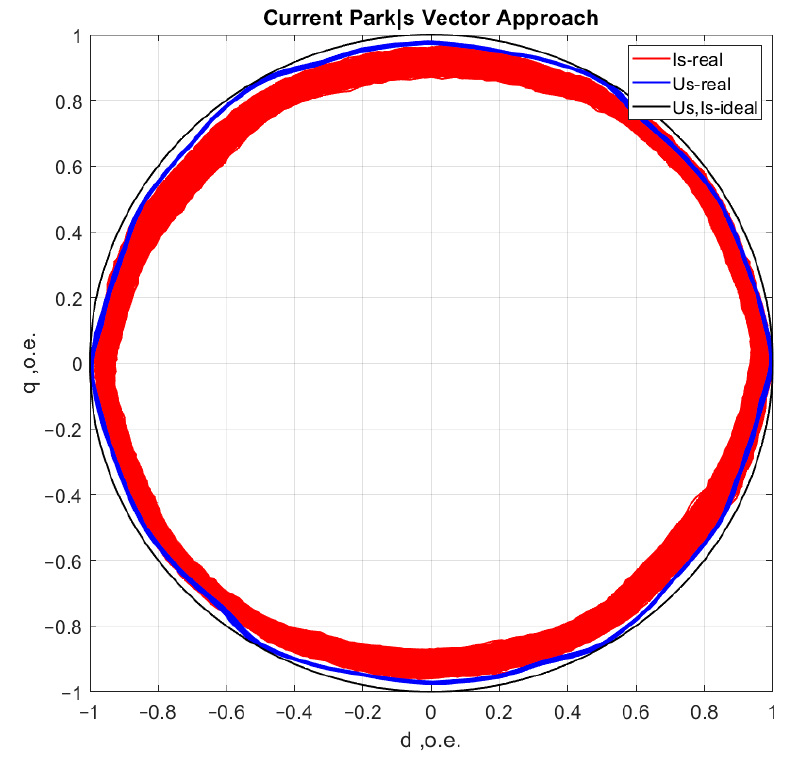
Figure 7. Motor operation in reference condition at rated load.